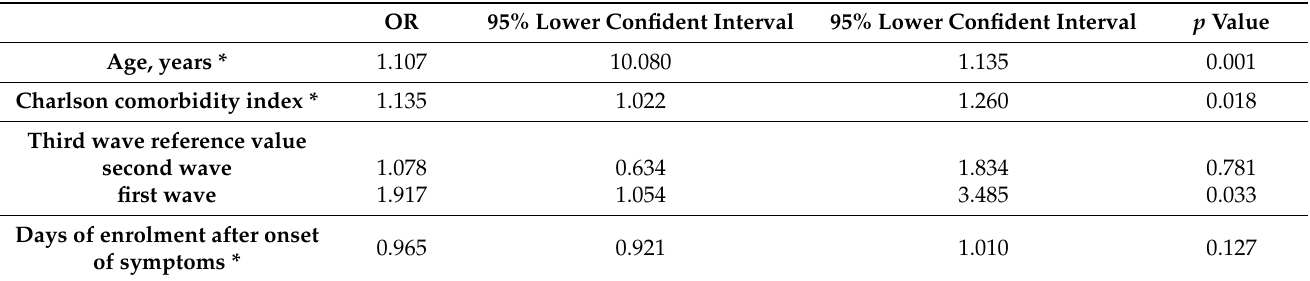
Table 4. Independent predictors of mortality at multivariable logistic regression